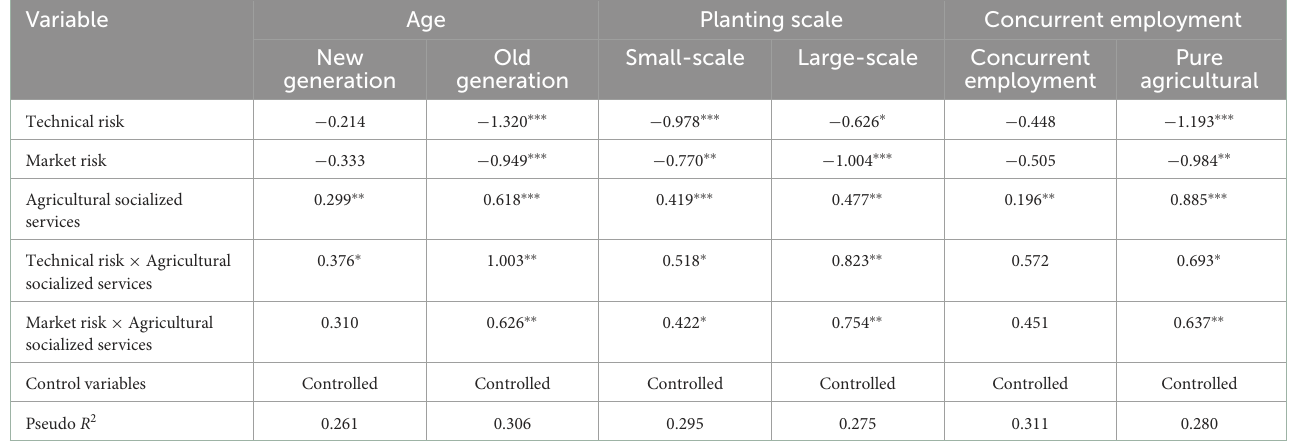
TABLE 6 Regression results of different groups of farmers. Variable Planting